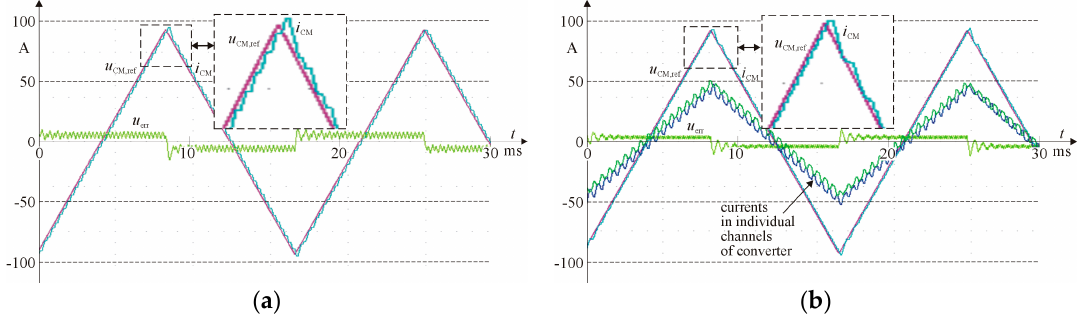
Figure 9. Waveforms in the simulation model of the current modulator, where its output current is equal to the nominal value, in two versions of the CCN: ( a ) single-channel; ( b ) dual-channel (interleaved) converter.